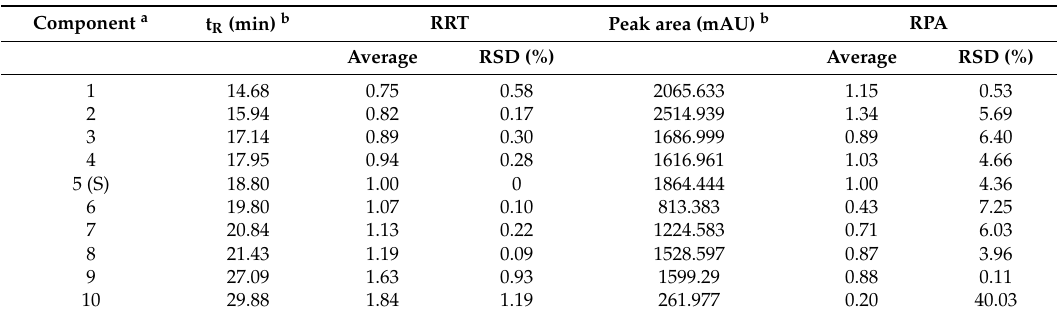
Table 2. The retention time (t R ), peak area (PA), relative peak relative retention time (RRT), and relative peak area (RPA) of 10 characteristic peaks in the bilberry reference extract and bilberry extract samples ( n = 3).